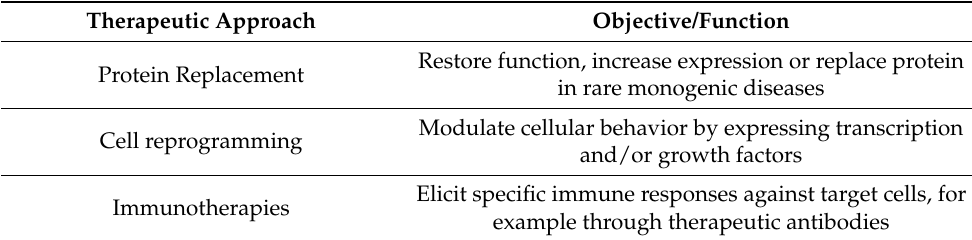
Table 2. Therapeutic approaches based on mRNA and their functions.